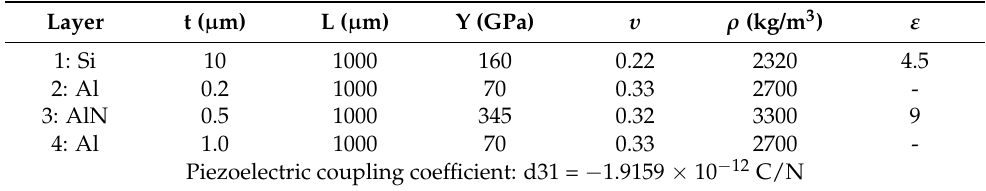
Table 4. Geometry and material parameters of the piezoelectric resonator.